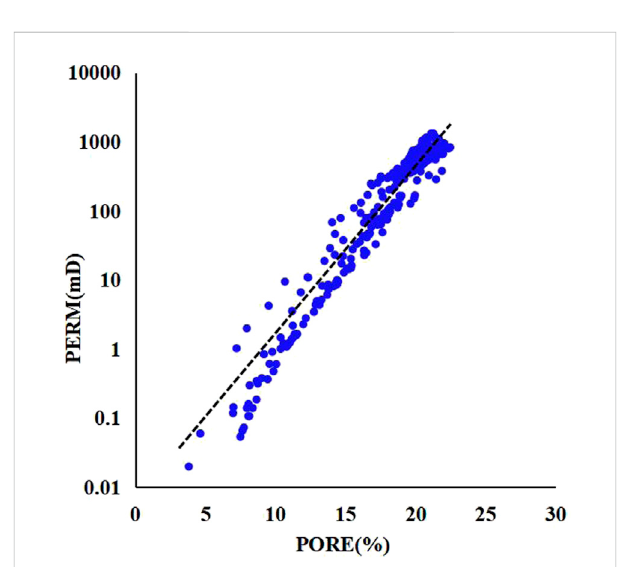
FIGURE 2 Crossplot of porosity and permeability of the main oil reservoirs in the Huizhou M oil fi